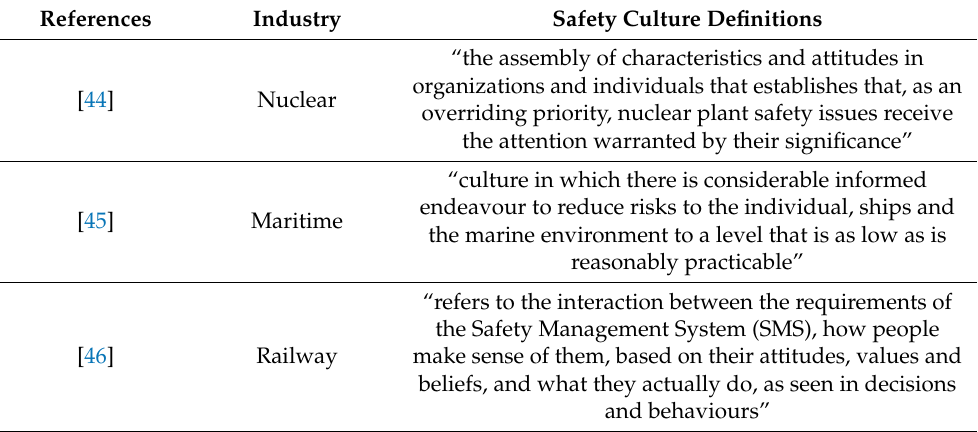
Table 2. Examples of industry safety culture